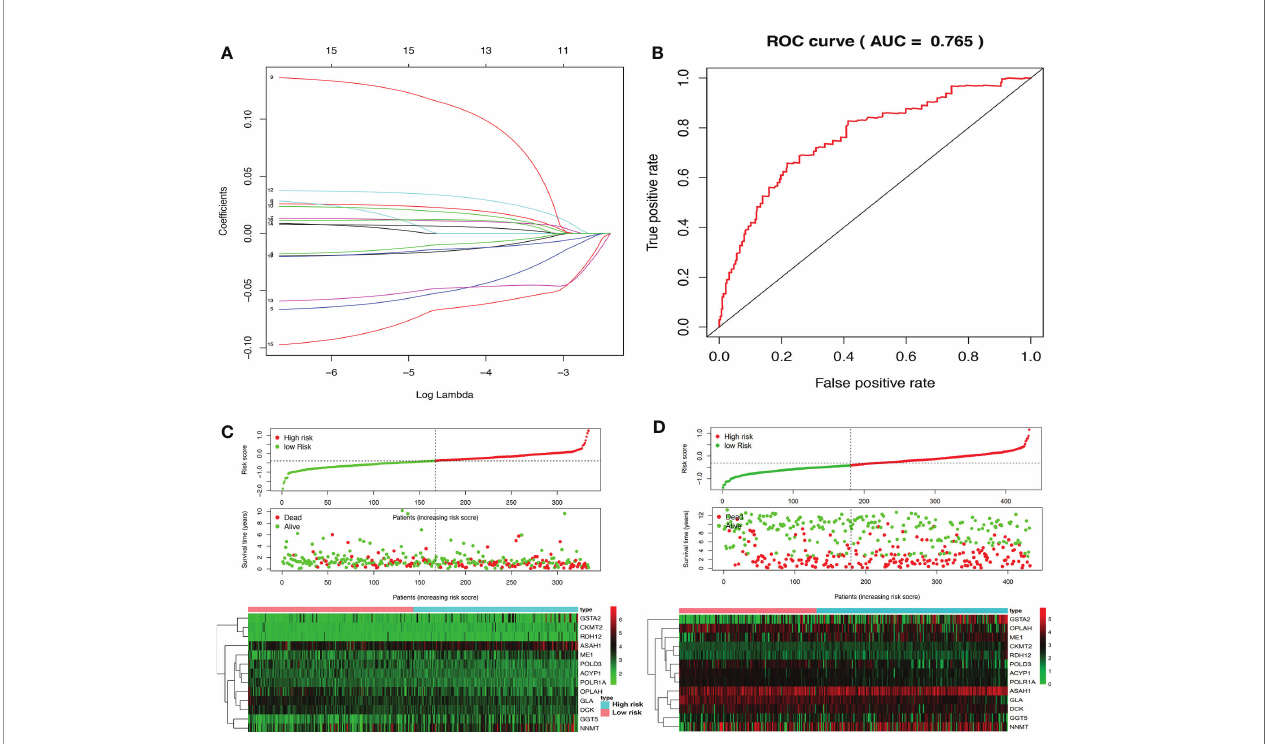
FIGURE 5 | Lasso regression identi fi ed the prognostic model in adenocarcinoma (STAD). (A) Lasso regression complexity was controlled by lambda using the ‘ glmnet ’ package in R. (B) The receiver operating characteristic (ROC) score in STAD based on The Cancer Genome Atlas (TCGA) data. (C) Riskplot heatmap between high- and low-risk score groups based on TCGA data. (D) Riskplot between high- and low-risk score groups based on n GEO